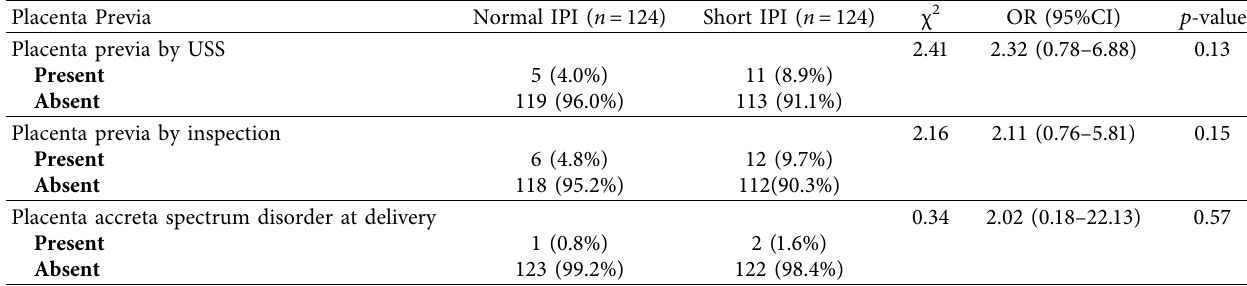
Table 3: Comparison of the incidence of placenta previa and placenta accreta spectrum disorder between women with a normal and short interpregnancy